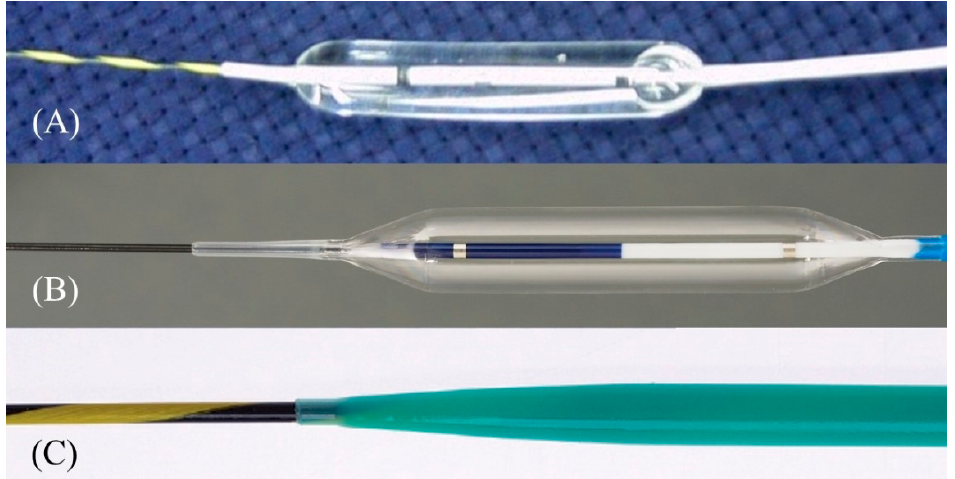
Figure 14. One-step mechanical dilation devices. Hurricane (Boston Scientific) is a balloon dilator with a rigid shaft and stylet (Courtesy of Boston Scientific) ( A ). REN (Kaneka Medics) is a balloon dilator with an ultra-tapered tip adapted to a 0.025 inch guidewire (Courtesy of Kaneka Medics) ( B ). ES dilator (Zeon Medical) is a bougie dilator with an ultra-tapered tip adapted to a 0.025 inch guidewire. (Courtesy of Zeon Medical) ( C ).